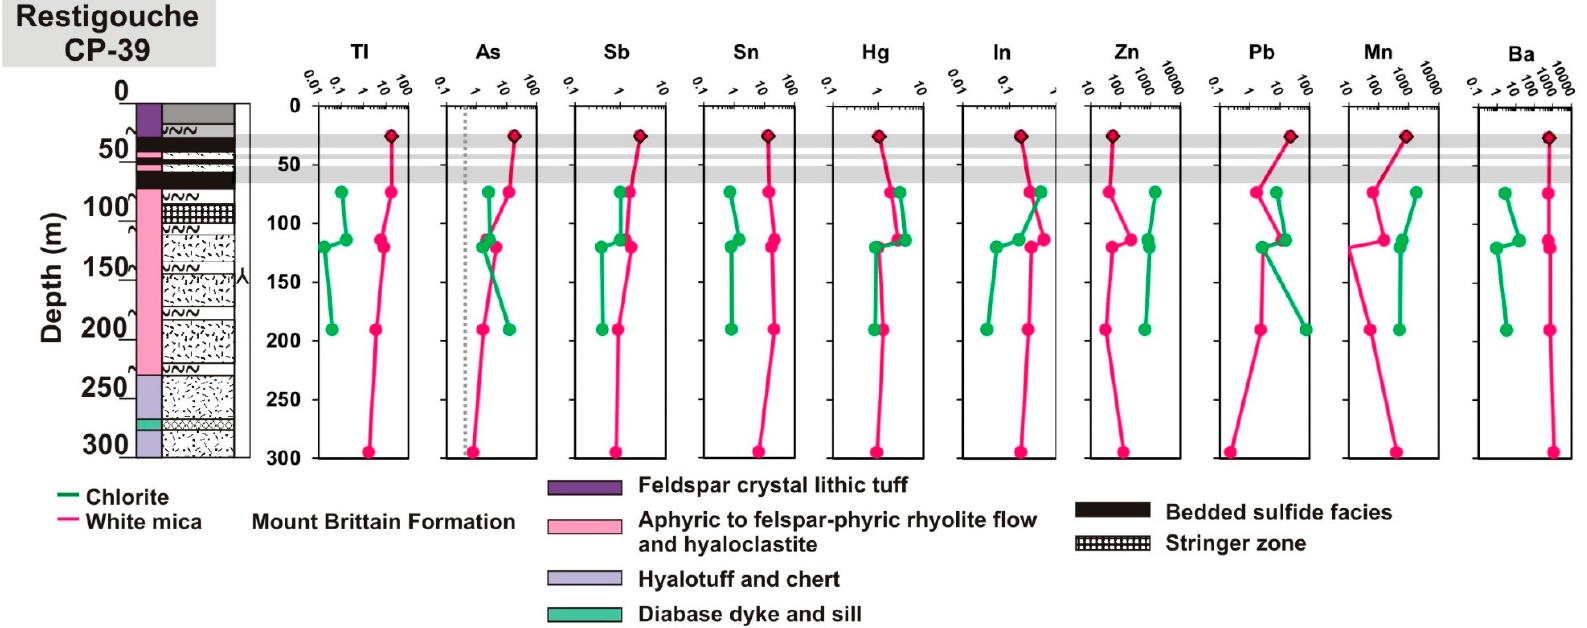
Figure 14. LA-ICP-MS geochemical data profiles illustrating fluid-mobile trace elements, as well as Zn, Pb, Mn, and Ba content (in ppm) of white mica plotted with respect stratigraphy of the Heath Steele B zone deposit intersected by drill hole HSB-3409 (see Supplementary Tables S6 and S7). Black outline symbols denote hanging wall samples.